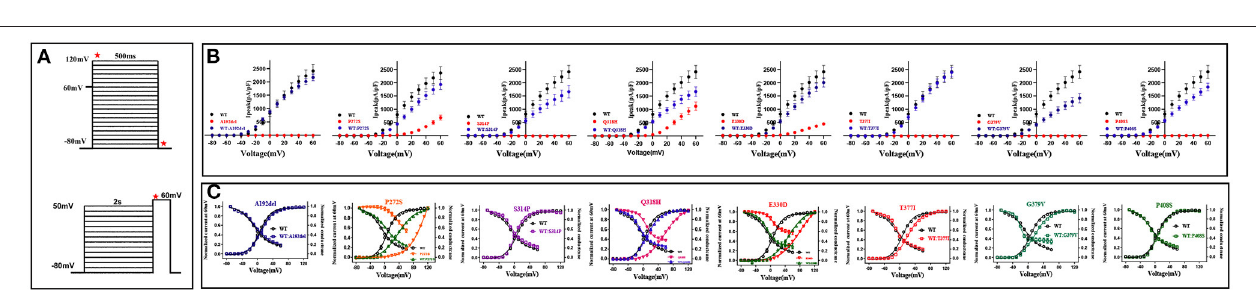
FIGURE 2 | Biophysical properties of KCNB1 variants detected in the study. (A) The voltage protocols used for electrophysiological studies are depicted. In the above image, Ipeak densities of KCNB1 variants were recorded at a voltage from − 80 to + 60mV, activation curves were generated at a voltage from − 80 to + 120mV. Inactivation curves were recorded as the below figure. Red stars indicate time points of the current measurement. (B) Comparison of Ipeak density of KCNB1 variants in homomeric and heteromeric configurations. (C) Voltage-dependence of activation/inactivation curves of KCNB1 variants in homomeric and (or) heteromeric